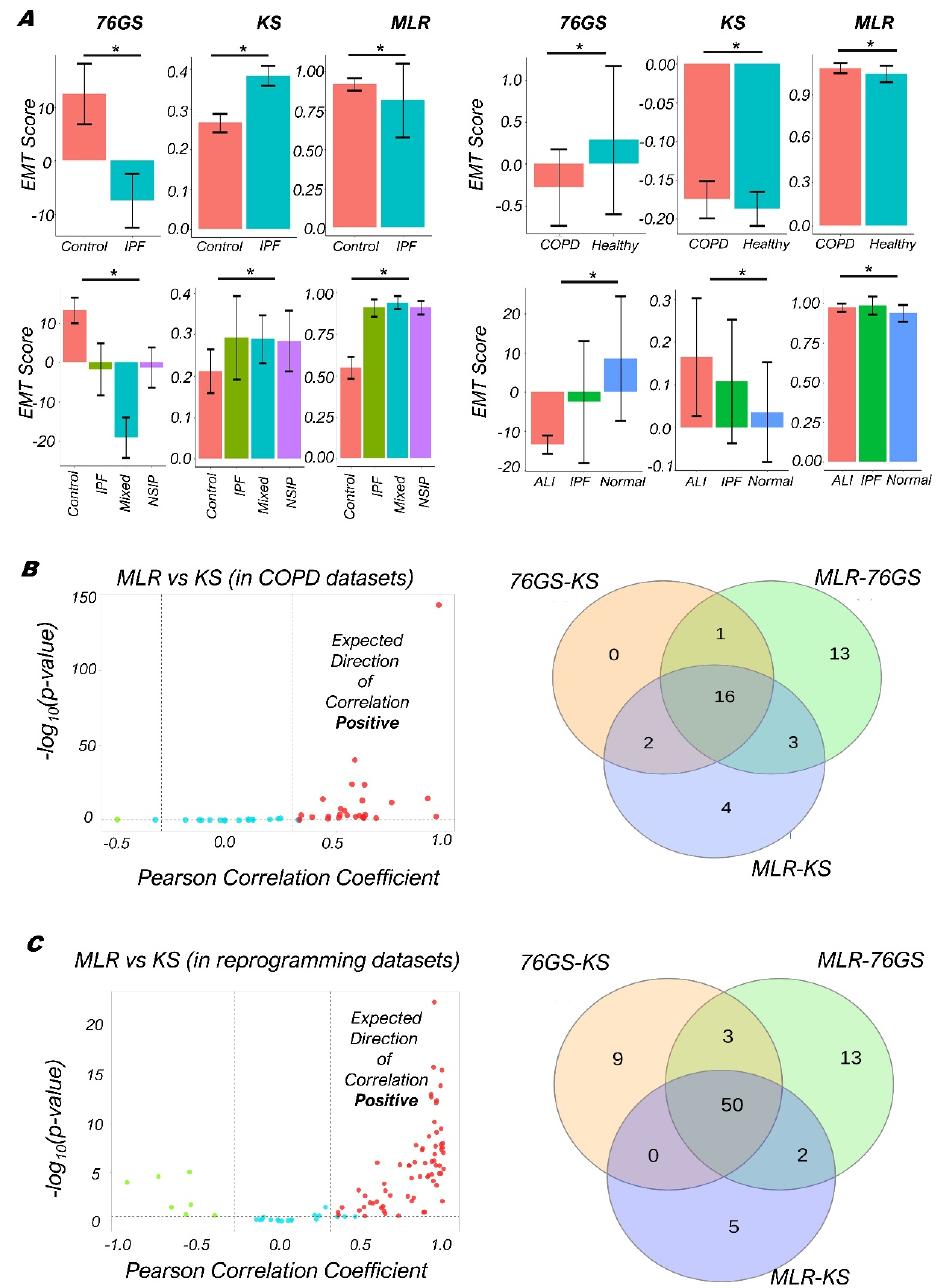
Figure 4. Concordance across all three EMT scoring methods in COPD/IPF and reprogramming datasets. ( A ) Bar plots showing EMT scores of different datasets calculated using three EMT scoring methods—(i) Lung tissues of healthy cases and IPF patients (GSE72073), (ii) EMT status in BAL cells of healthy volunteers and COPD patients (GSE73395), (iii) Lung tissues of IPF, NSIP, and Mixed IPF/NSIP patients, as well as healthy lung tissue (GSE110147), (iv) EMT status in lung tissues of Normal, ALI, and IPF patients (GSE134692). ( B ) (Left) Plots of the correlation of MLR vs. KS EMT scoring metrics across 46 datasets. For each sample, − log10 ( p -value) is plotted as a function of Pearson’s correlation coefficient. Thresholds for correlation ( R < − 0.3 or R > 0.3; vertical dashed grey lines) and p -values ( p < 0.05; horizontal dashed grey lines) are shown. (Right) Venn diagram depicting the common datasets across all pairwise comparisons that are significantly correlated in the expected direction. ( C ) Same as ( B ) but for reprogramming associated datasets. *: p < 0.05 for Students’ t